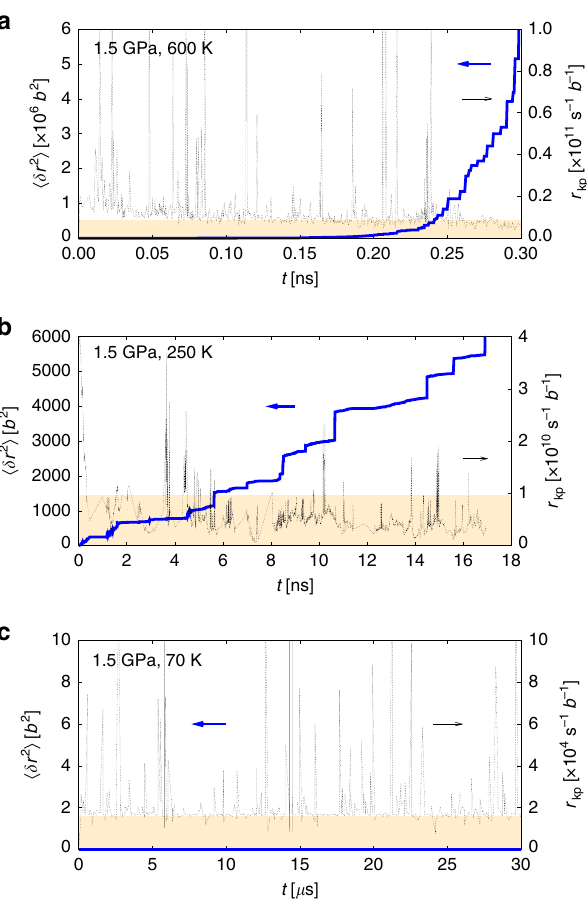
Fig. 4 Solute migration is coupled to dislocation behavior. Evolution of the solute mean square displacement and kink-pair nucleation rates with time. Fig. 5 Geometric distribution of solute around dislocation lines.